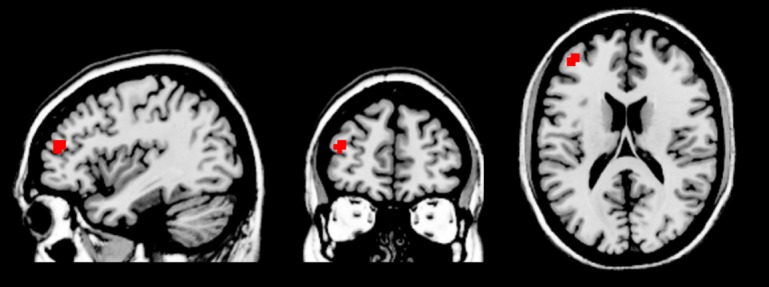
Increased left middle frontal gyrus (two clusters, peak coordinates: x = –39, y = 48, z = 18) activation in the MDD group compared to controls during the gender judgment task.